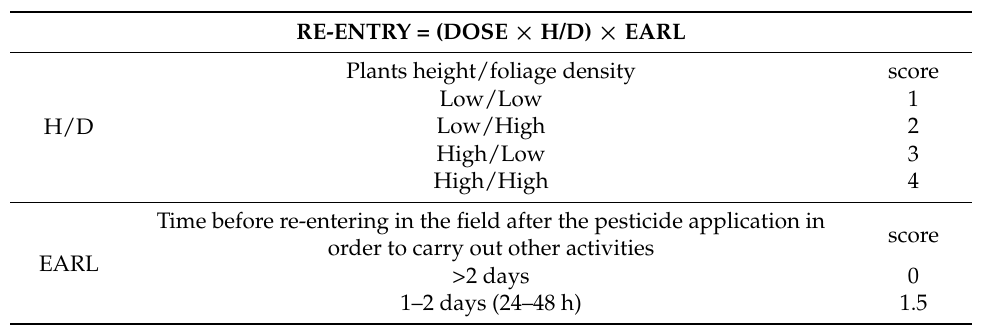
Table 6. Exposure factors during re-entry activities.